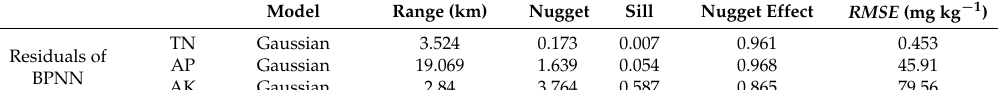
Table 6. Semivariogram analysis of OK residuals of BPNN model for soil nutrients.